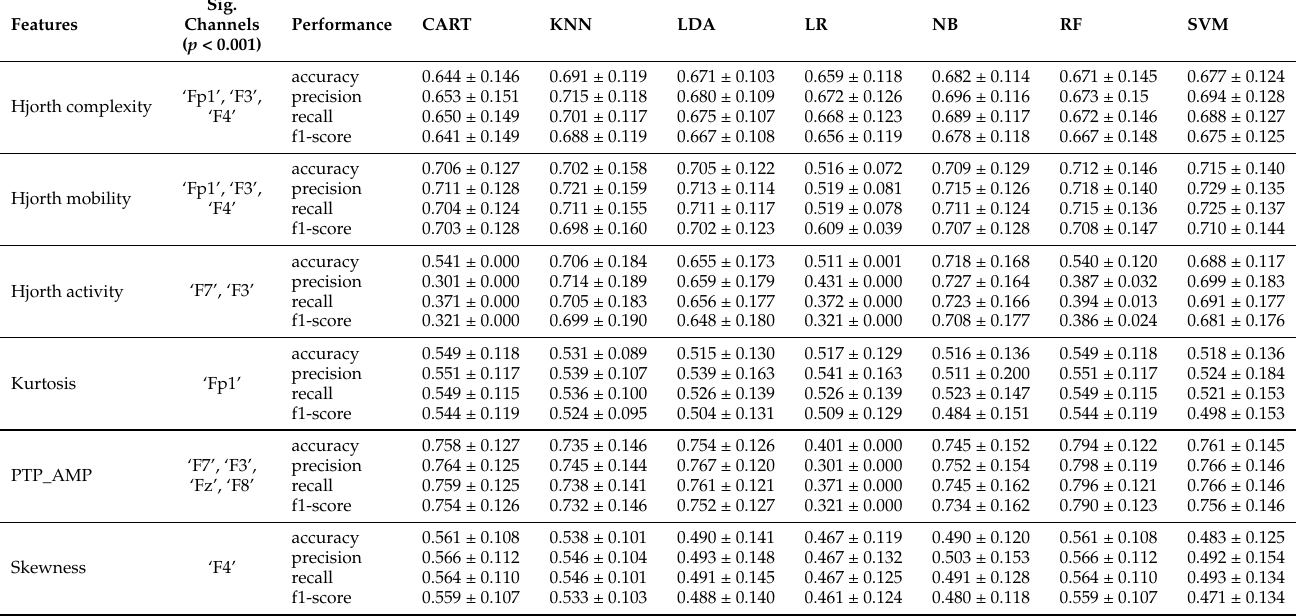
Table 3. The average accuracies and standard deviations of significant time-domain features from the selected channels with the seven